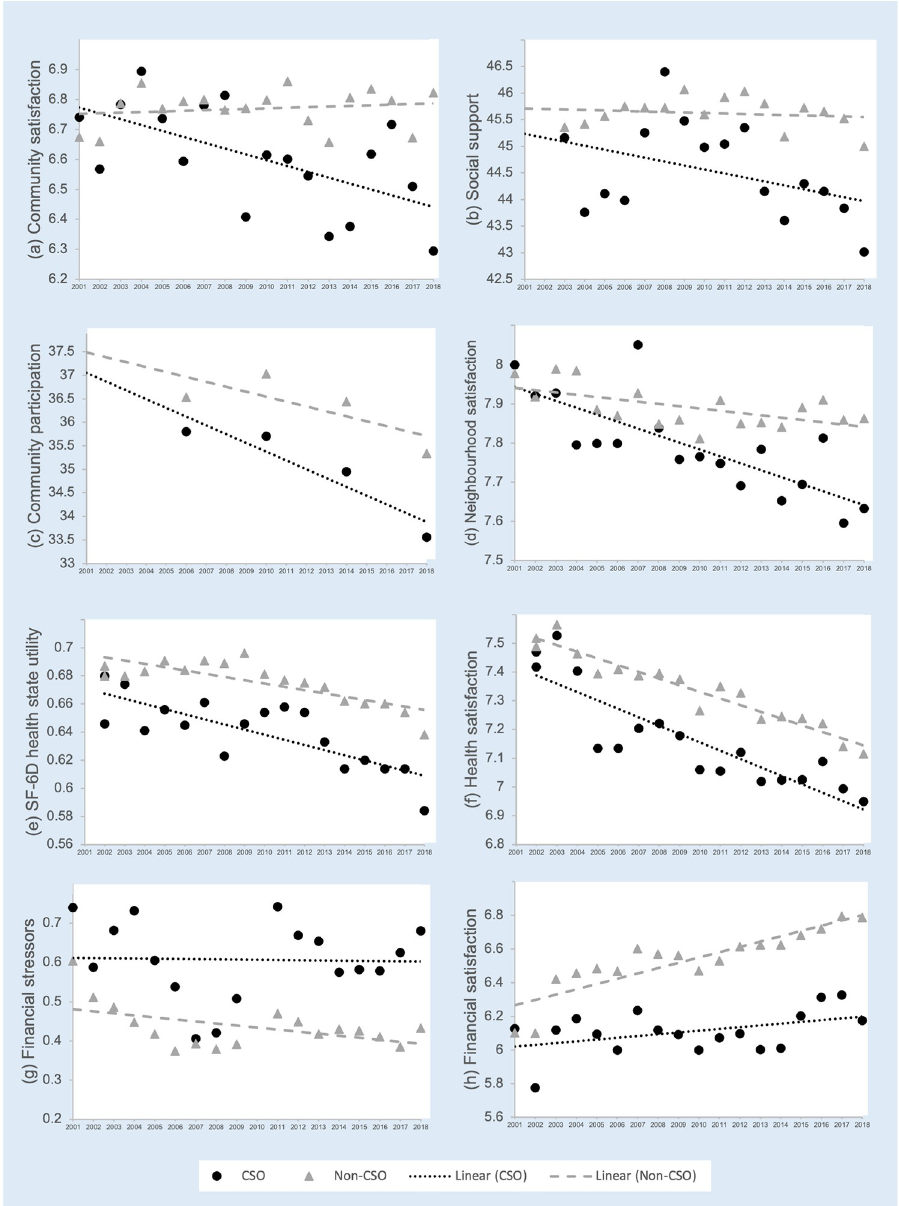
Fig 3. a-h. The trajectories of social, health and financial wellbeing for CSO and non-CSOs.